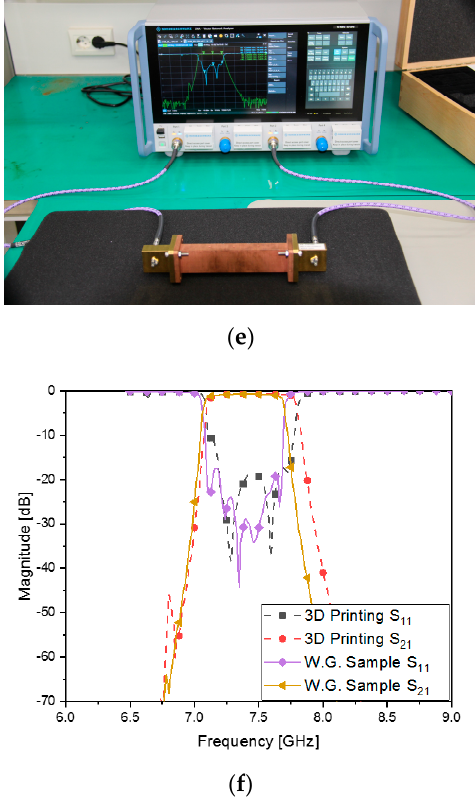
Figure 9. Prototyped eighth-order WG ZOR BPF via 3D-printing process: ( a ) basic idea of FDM [18], ( b ) the 3D printer employed here and its working mechanism [19], ( c ) front view of the inside garnished by the flange body, ( d ) top view of the 3D-printed filter, ( e ) our 3D-printed WG filter under test and ( f ) S 11 and S 21.